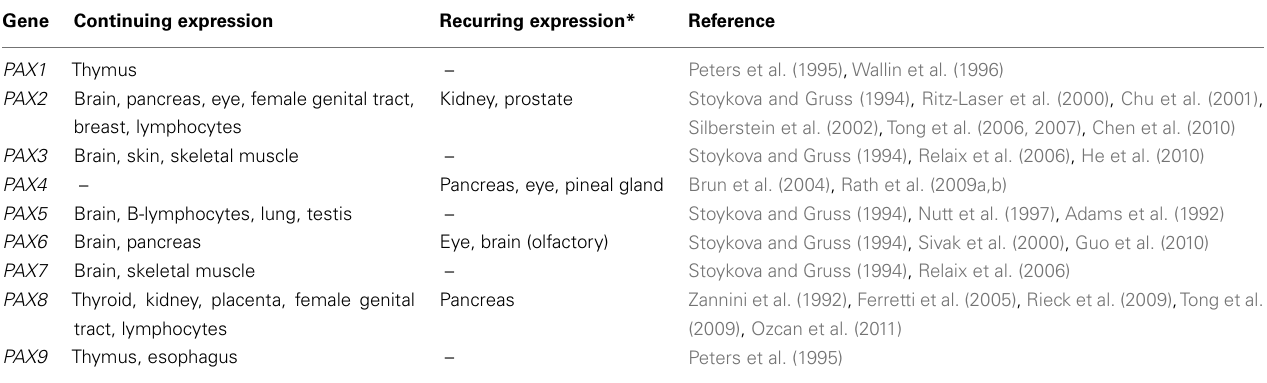
Table 1 | Continuing and recurring expression of PAX genes in adult